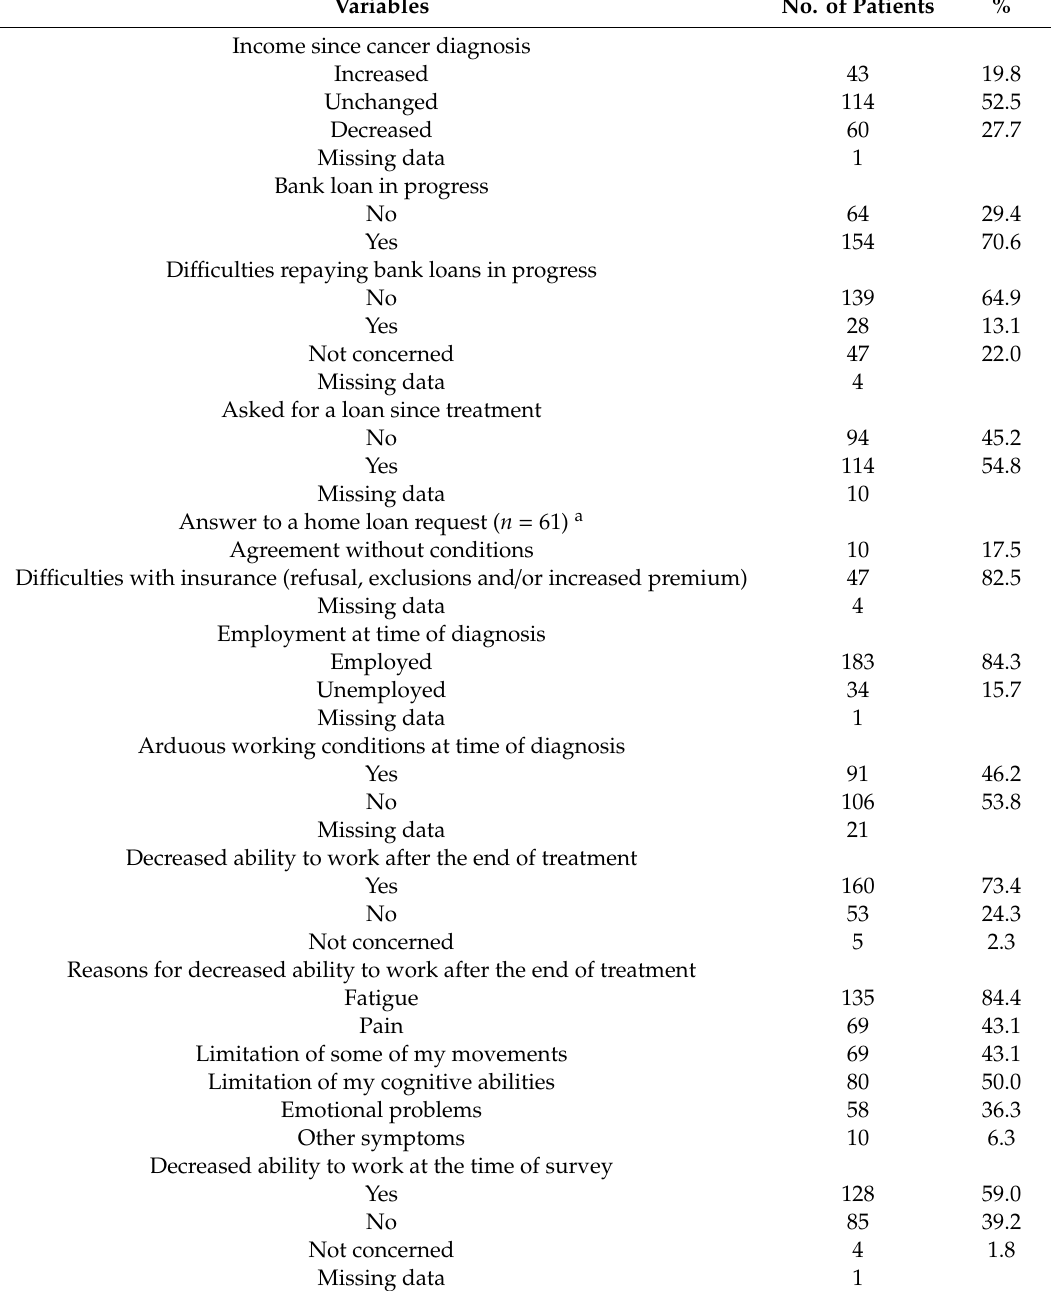
Table 5. Professional outcomes in the study